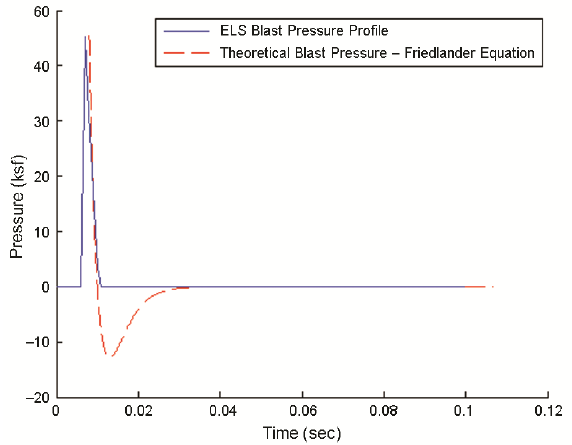
Fig. 8. Sample blast pressure-time profile: linear approximation vs. theoretical profile (1 ksf = 48